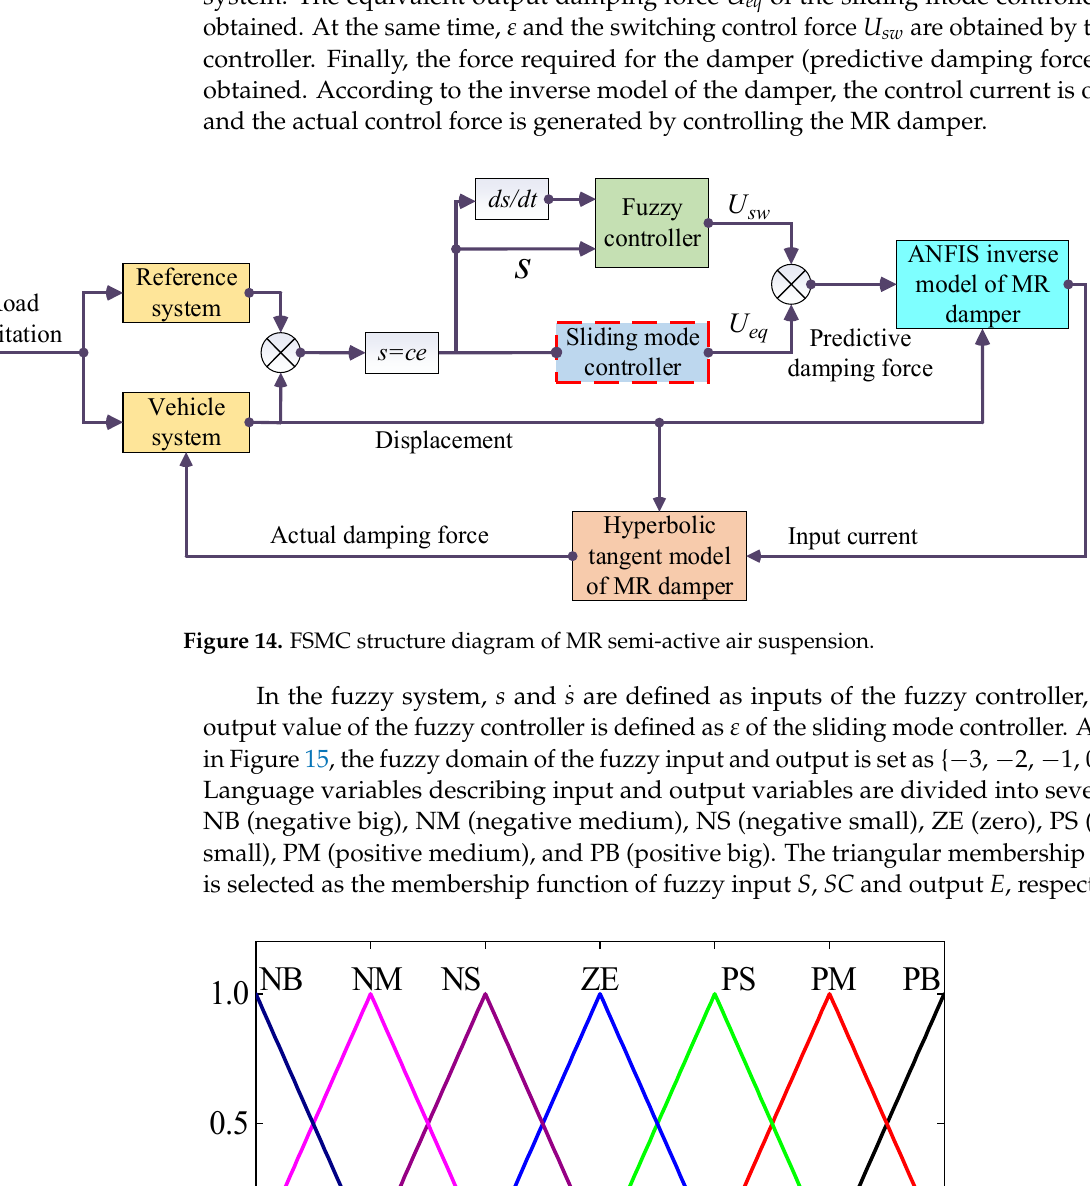
Figure 15. Membership function of input and output variables.